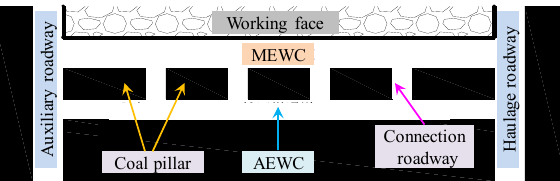
Figure 1. Schematic diagram of the pre-excavation equipment withdrawal channels (EWCs). MEWC: main equipment withdrawal channel; AEWC: auxiliary equipment withdrawal channel.